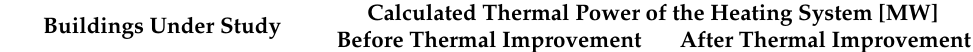
Table 3. Energy performance of surveyed buildings before and after thermal improvements